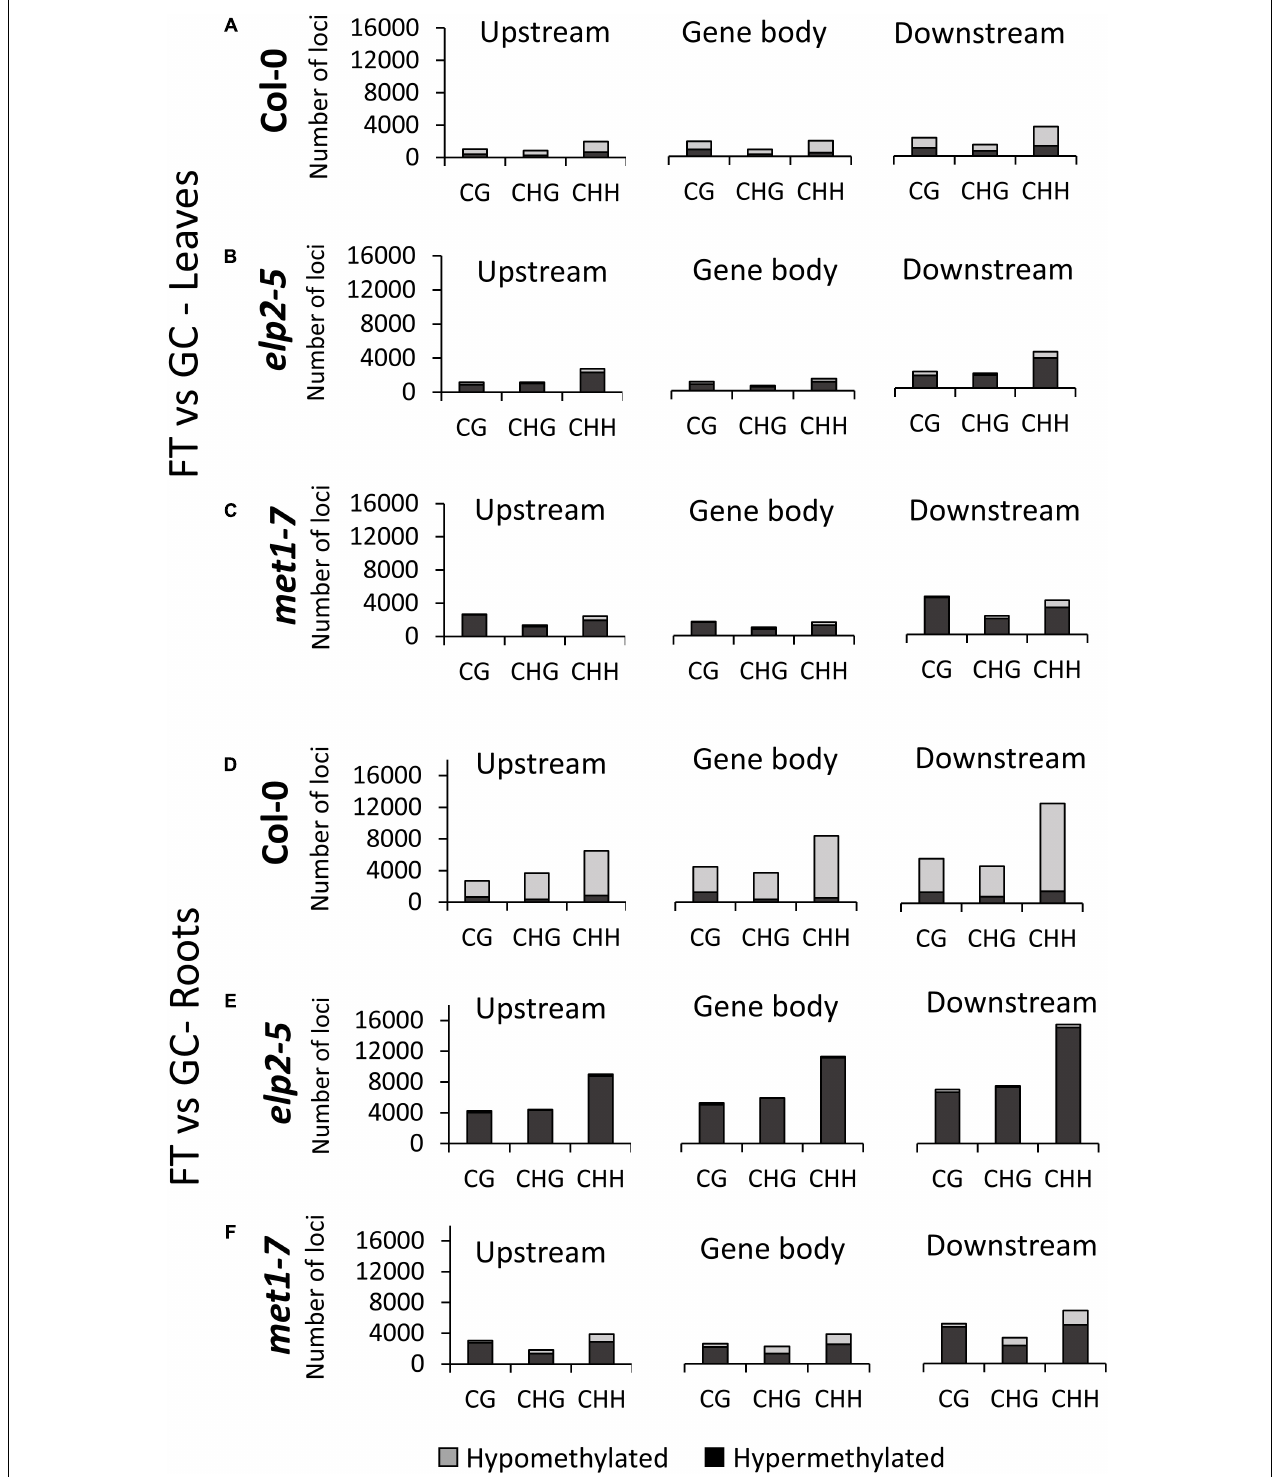
FIGURE 5 | Methylation context breakdown of DmCs mapped to different genic features in spaceflight vs ground comparisons. Leaf and Root DMCs of Col-0 (A,D) elp2-5 (B,E) , and met1-7 (C,F) in response to spaceflight are mapped to genic features such as; upstream (2,000 bp upstream of the transcription start site), gene body (exons, introns, and both 5 (cid:48) and 3 (cid:48) UTRs), and downstream (2,000 bp downstream of the polyadenylation site). The corresponding methylation direction in each context is also illustrated – Hypomethylation (Hypo) gray and Hypermethylation (Hyper) black.